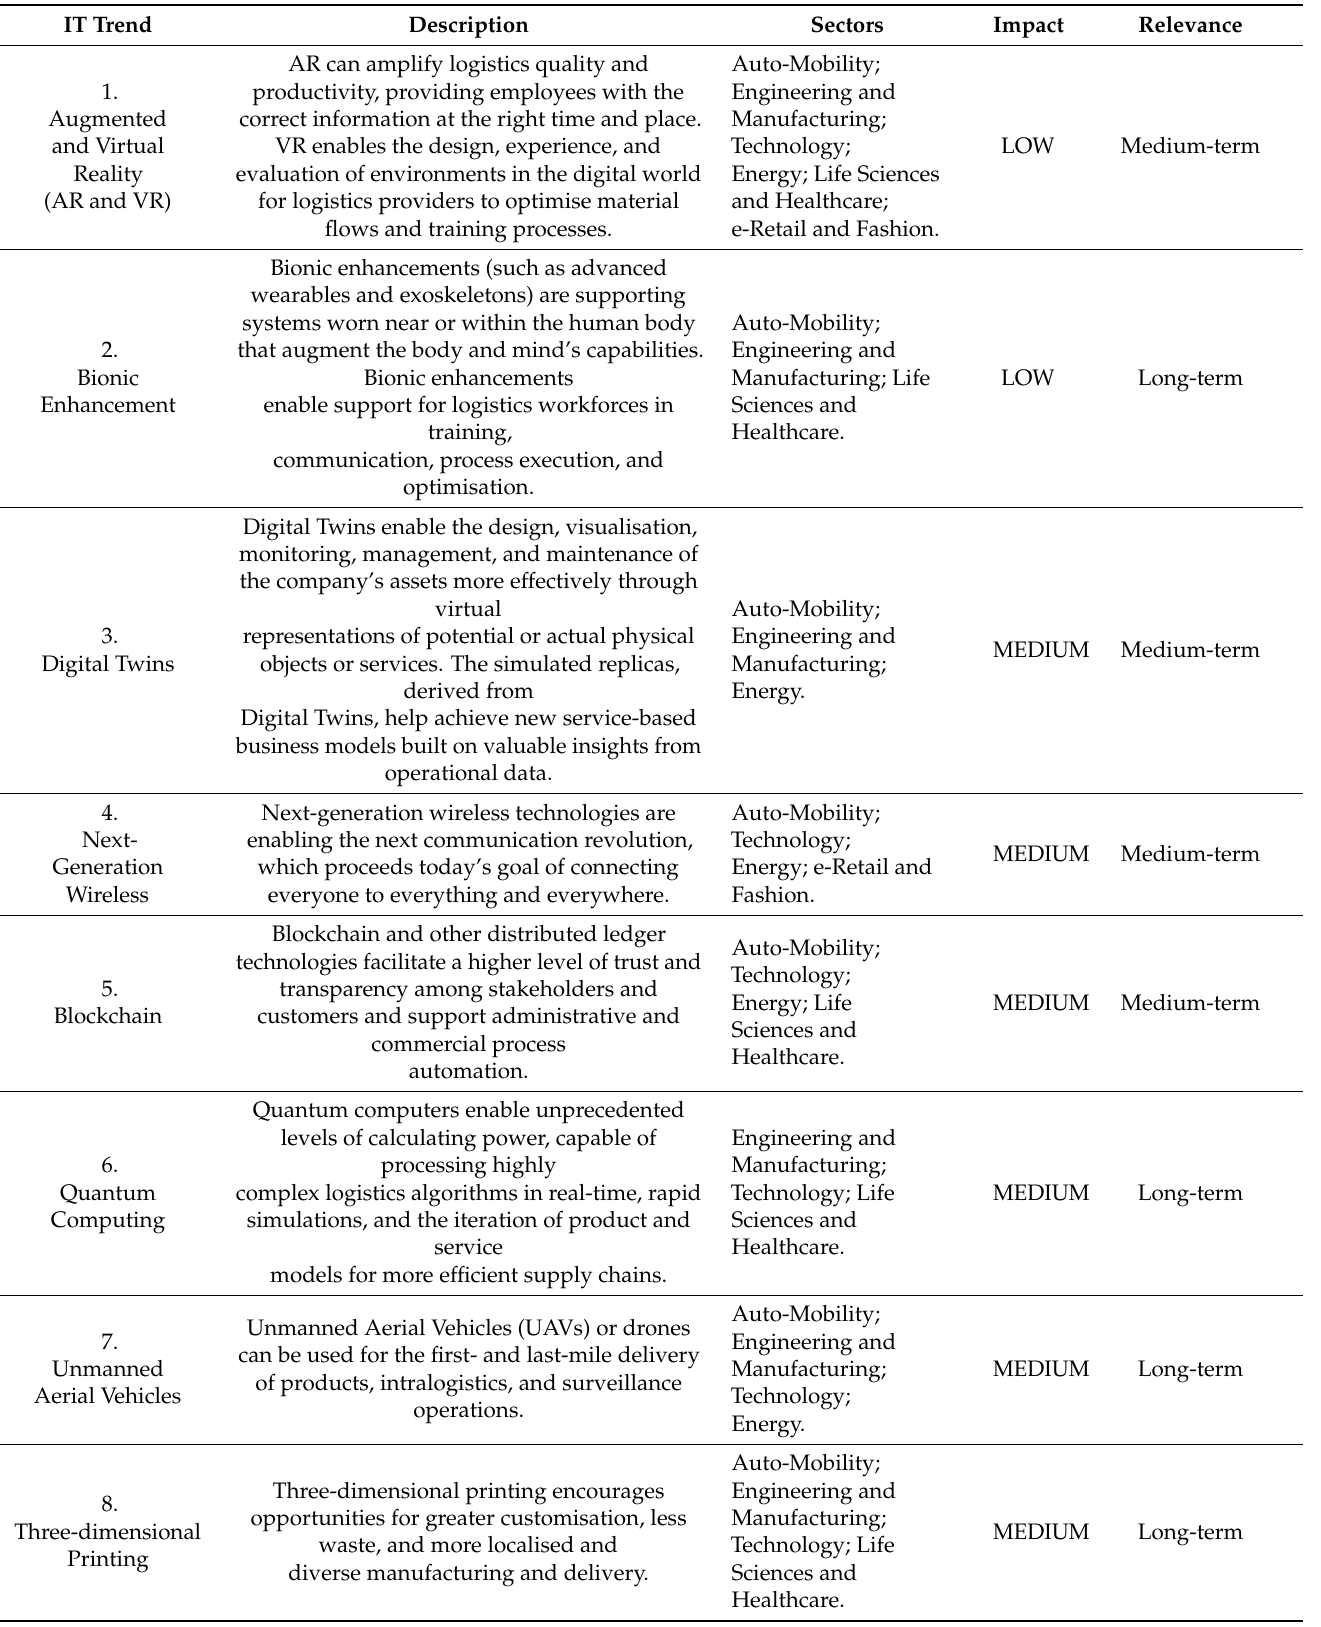
Table 1. IT trends’ risk assessment, adapted from